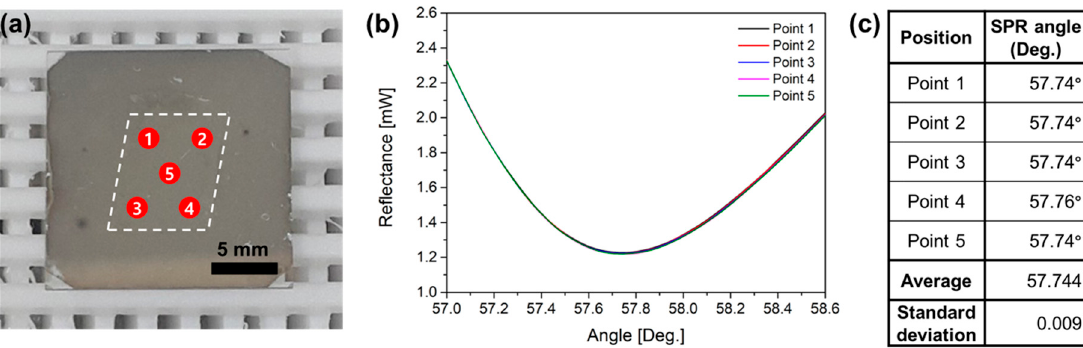
Figure 6. ( a ) The fabricated Ag/MoS 2 sample and five SPR measurement points in red circles. ( b ) SPR curves of the Ag/MoS 2 sample obtained at the five different positions. ( c ) Summary table of SPR angles and average value.